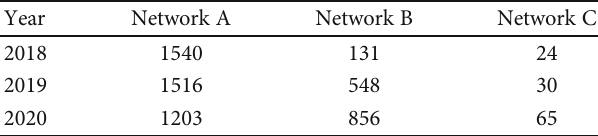
Table 4: Referral rates during the fi rst six months of